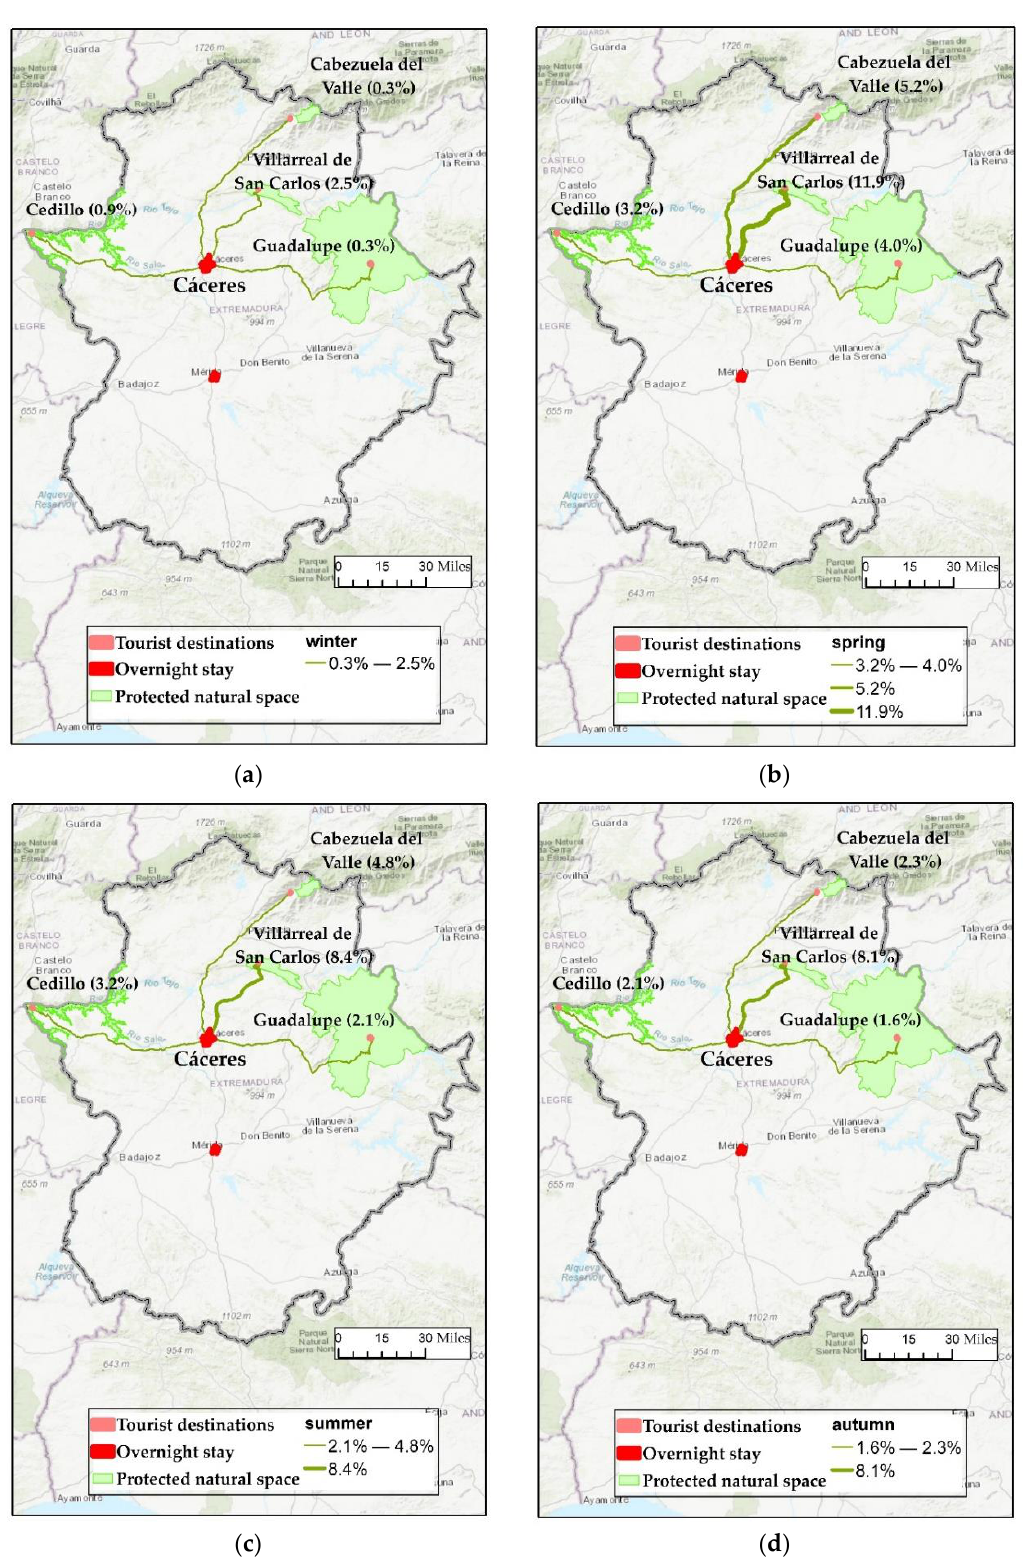
Figure 4. Journeys made by tourists spending the night in C á ceres: ( a ) winter; ( b ) spring; ( c ) summer; ( d )